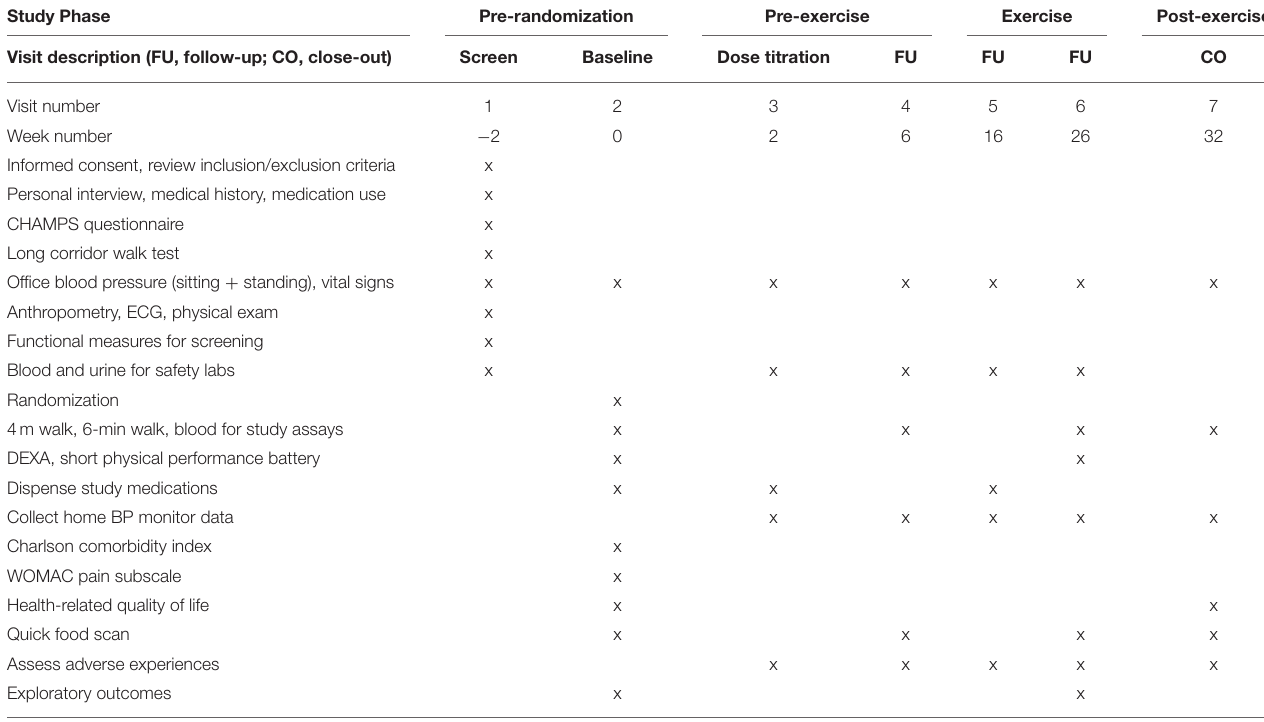
TABLE 2 | Data collection summary via assessment